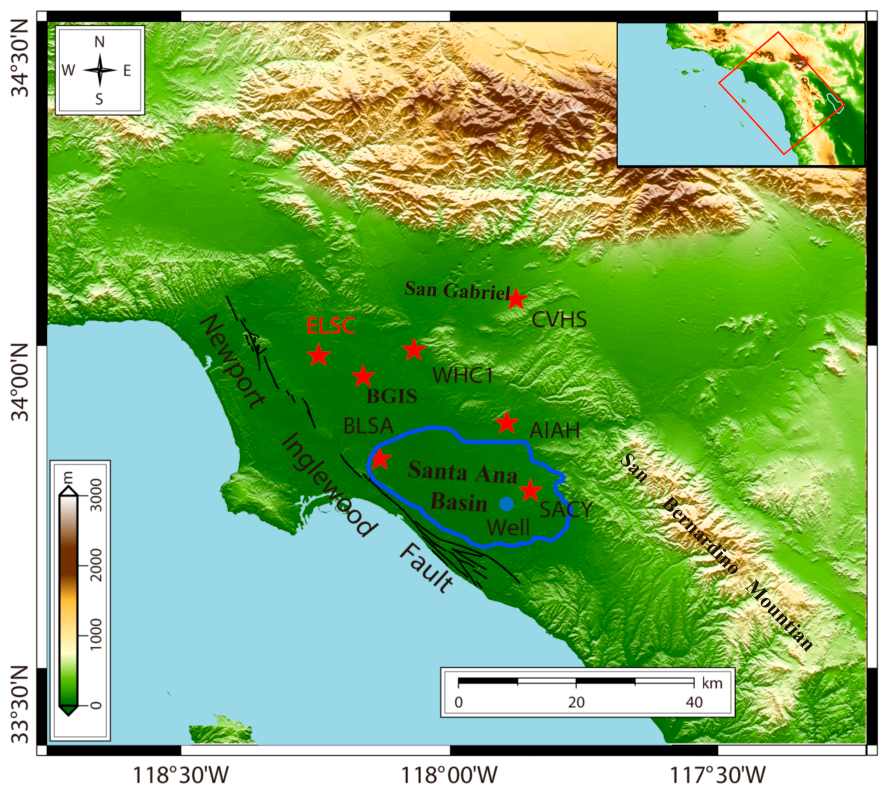
Figure 2. Topographic map of the study area generated from SRTM DEM data with 30 m resolution. Red rectangle shows the coverage of the descending Sentinel-1 SAR images used here. Blue solid line outlines the investigated Santa Ana basin. Red stars show the locations of the 6 SCIGN GNSS sites for accuracy validation, and the ELSC GNSS station is selected as the reference point. Blue dot indicates the location of a groundwater well.